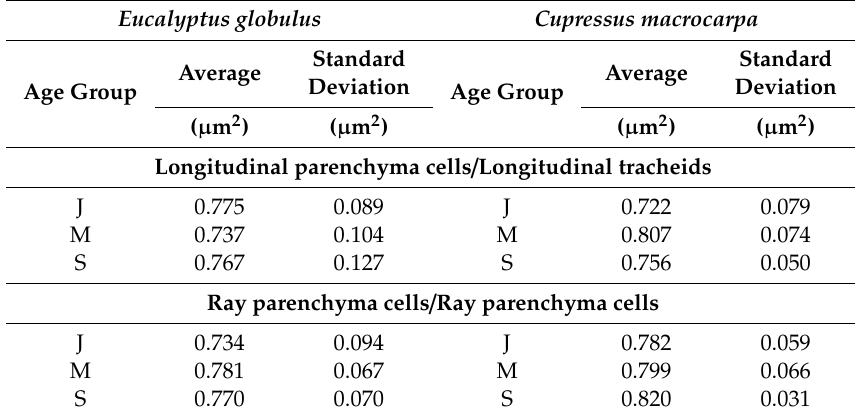
Table 2. Averages and standard deviations of roundness of the longitudinal parenchyma cells, longitudinal tracheids and ray parenchyma cells for Eucalyptus globulus and Cupressus macrocarpa per age group.